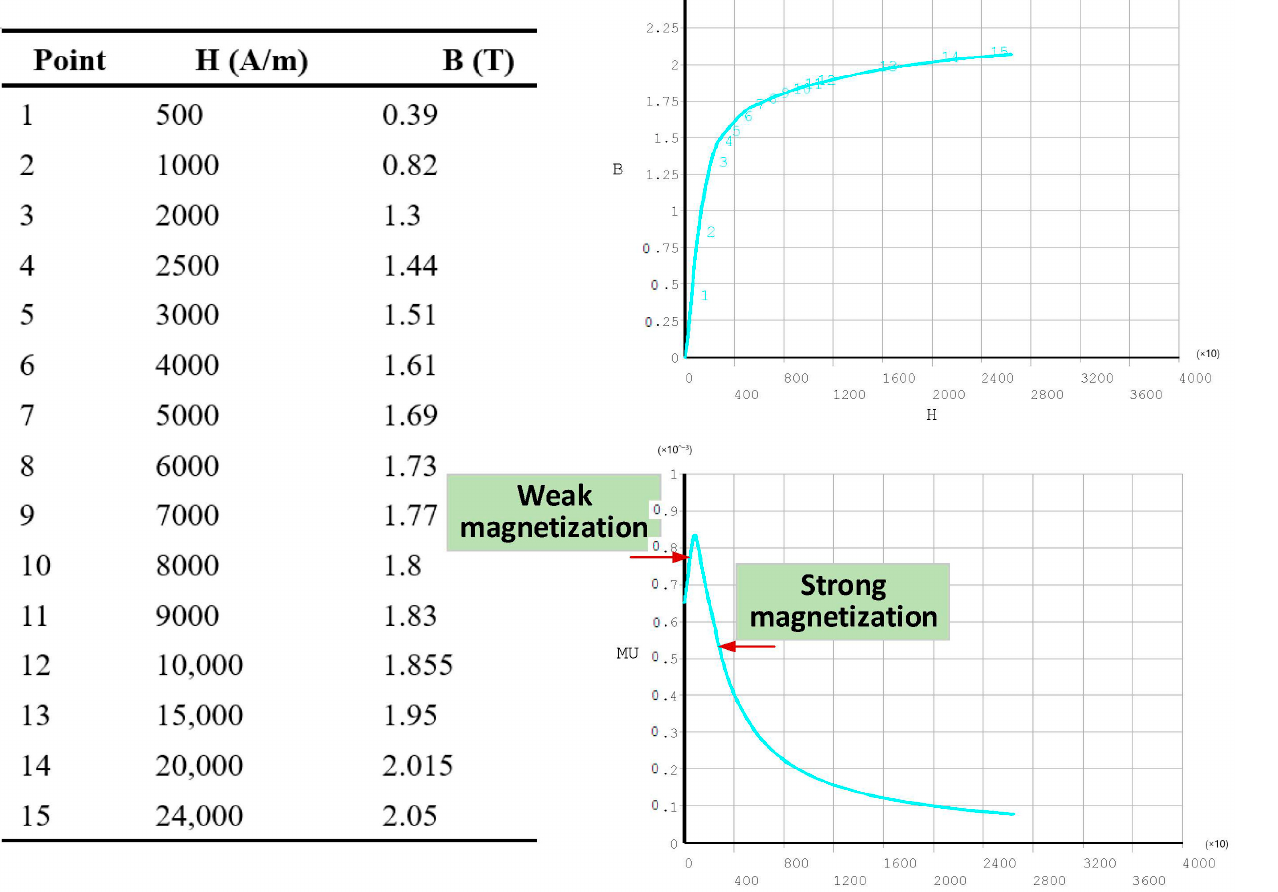
Figure 8. B-H curve of the material used in